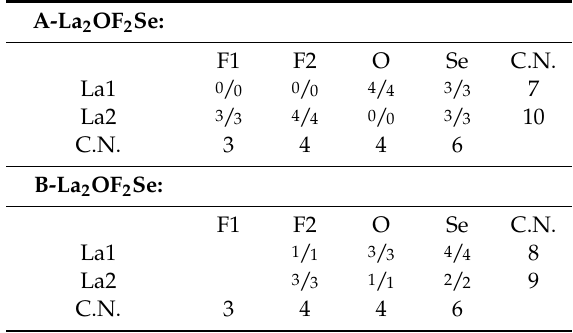
Table 6. Motifs of mutual adjunction in A- and B-type La 2 OF 2